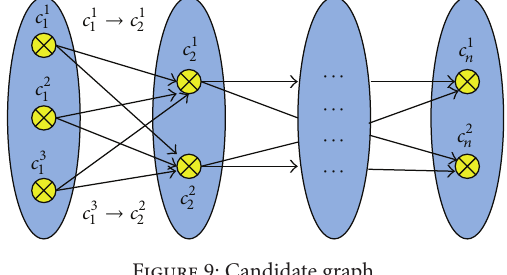
Figure 9: Candidate